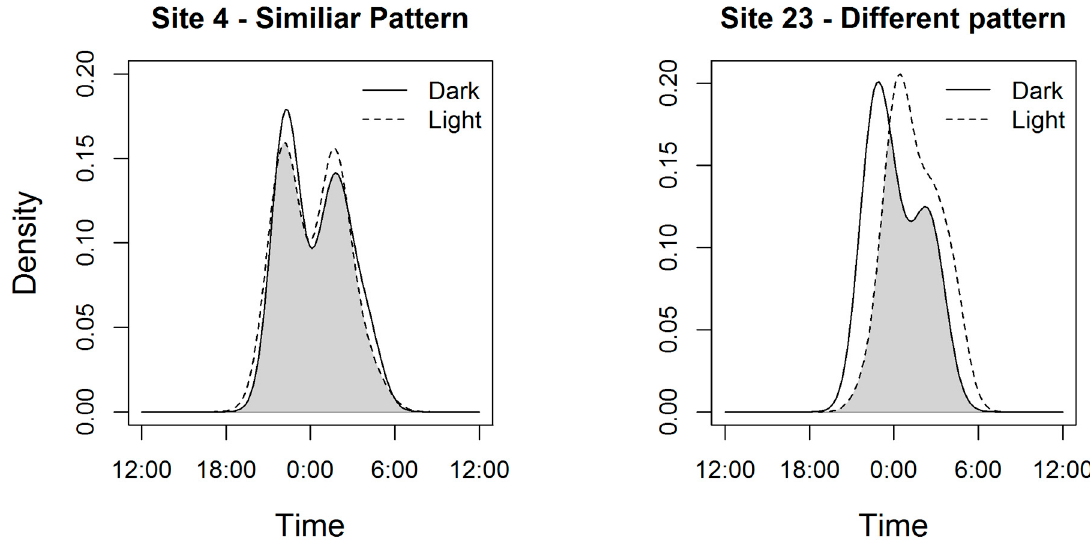
Figure 2. Examples of activity patterns at two different sites: hedgehog activity patterns did not change between treatments at site 4 ( Δ = 0.93, p = 0.78), but did at site 23 ( Δ = 0.70, p = 0.02), whereby hedgehogs shifted their activity to become active later at night when the light was on. The area shaded in grey is where the two patterns overlap ( Δ ).